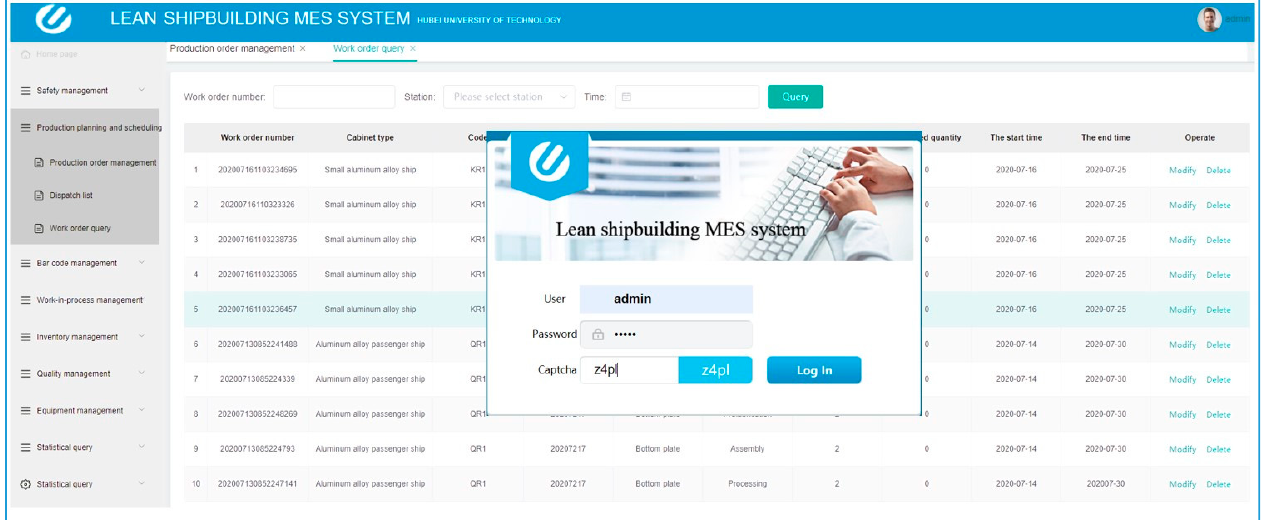
Table 3. The comparison of the shipyard’s production situation.